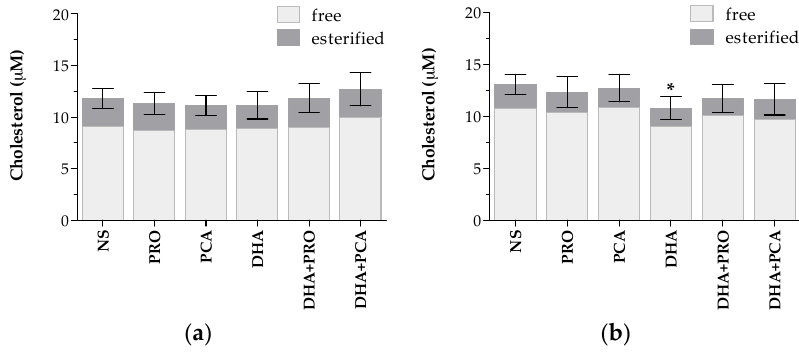
Figure 4. Intracellular cholesterol concentration in not supplemented (NS) and supplemented cells with docosahexaenoic acid (DHA), protocatechuic acid (PCA) and propionic acid (PRO) after ( a ) 6 h and ( b ) 24 h supplementation. Data are expressed in µM cholesterol per well, and are means ± standard deviation (SD) of five samples derived from three independent experiments. Statistical analysis was carried out by the one-way ANOVA (panels ( A , B ) p < 0.05) using Dunnett’s post-test to compare NS and supplemented cells (* p < 0.05).